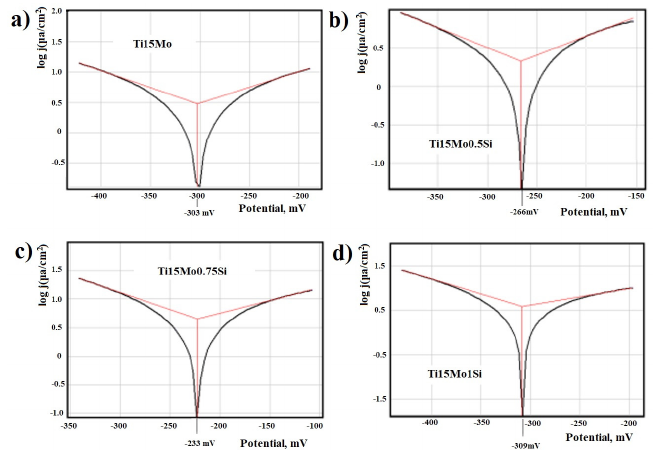
Figure 6. Tafel plots of coated samples investigated by corrosion testing in Ringer’s solution: ( a ) S1-ZrO 2 ; ( b ) S2-ZrO 2 ; ( c ) S3-ZrO 2 ; ( d ) S4-ZrO 2